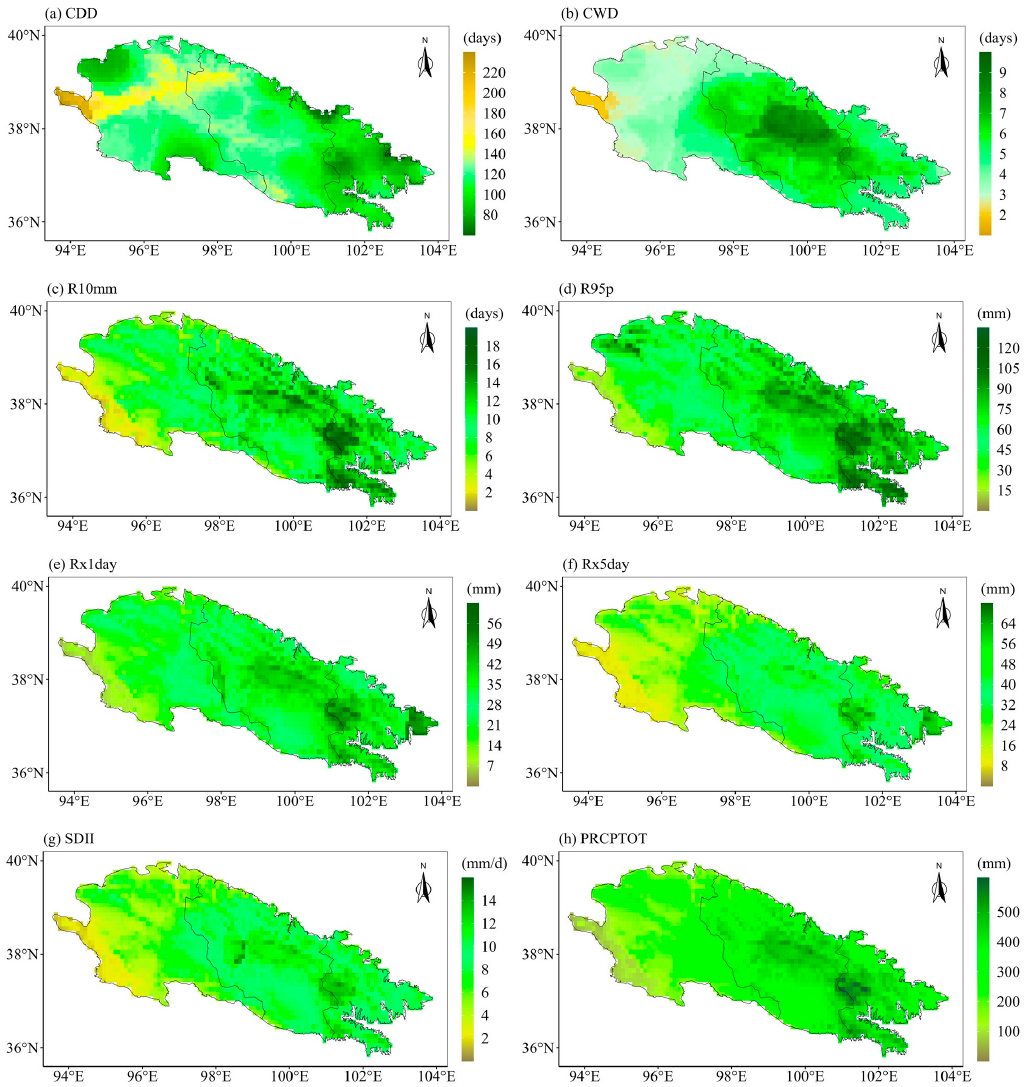
Figure 9. The spatial patterns of eight extreme precipitation indices in the Qilian Mountains during the base period (1981–2010).